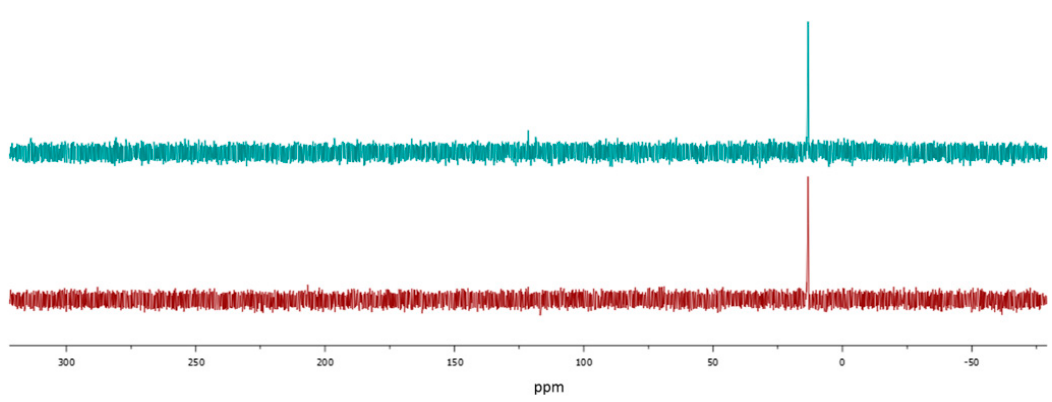
Figure 4 . 31 P ‐ NMR spectra of copolymer 10 ( top ) and 11 ( bottom ) in DMSO ‐ d 6 .